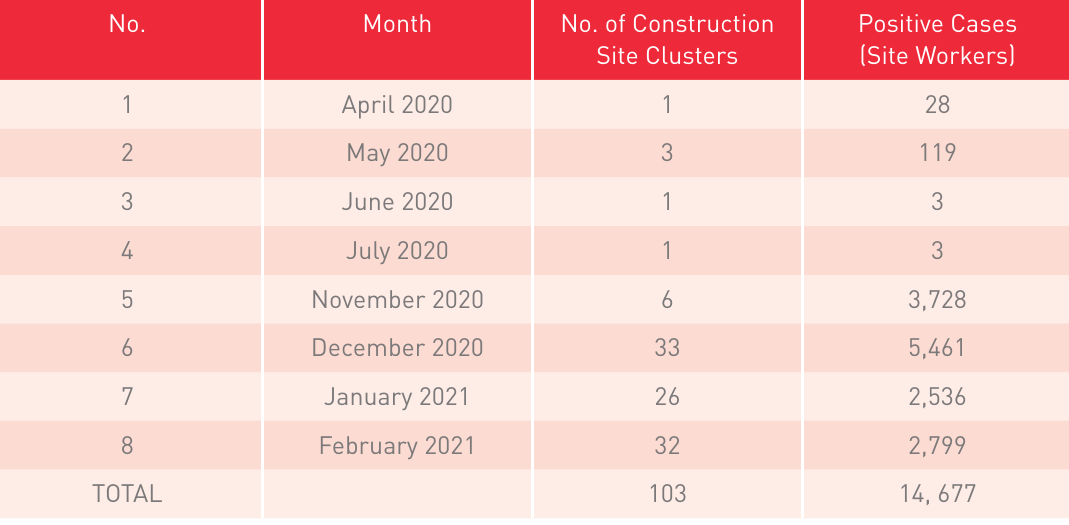
Table 1. Tabulation of Construction Site Clusters in Malaysia from April 2020 to February